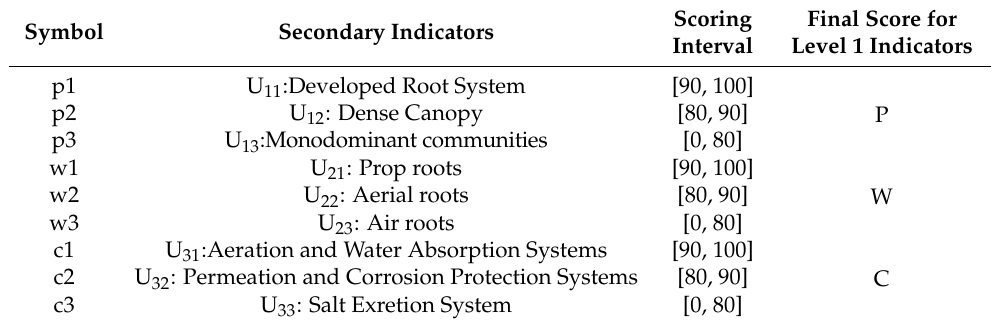
Table 4. The score of each secondary indicator.